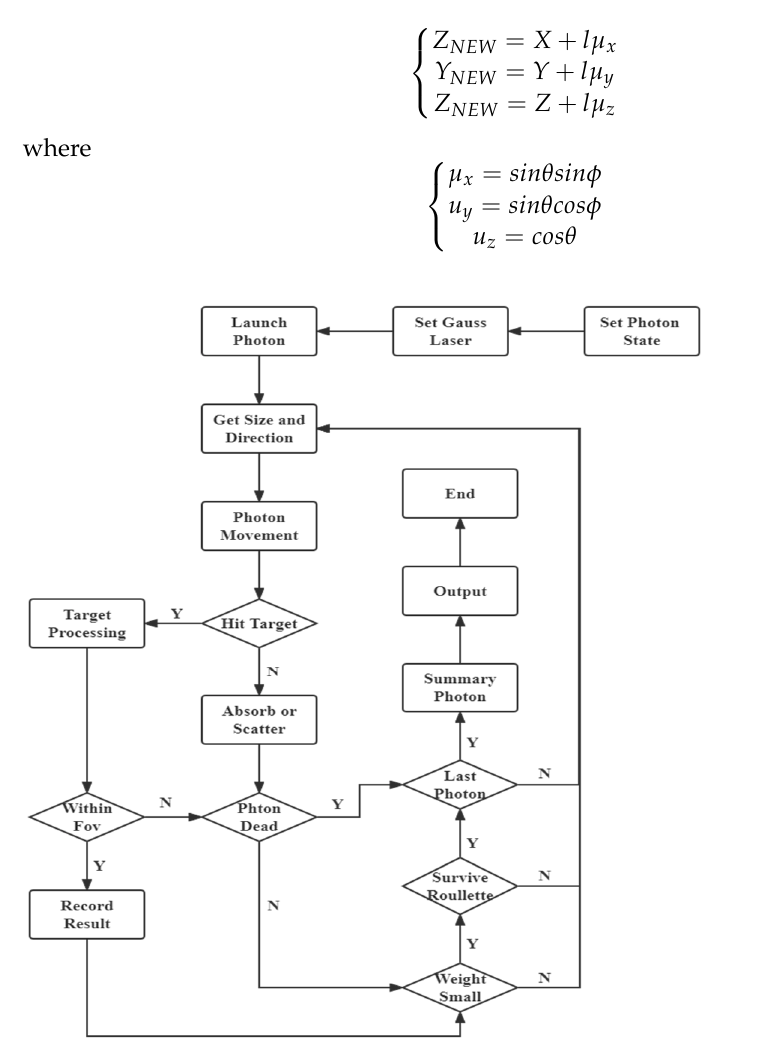
Figure 3. Monte Carlo method for detection.